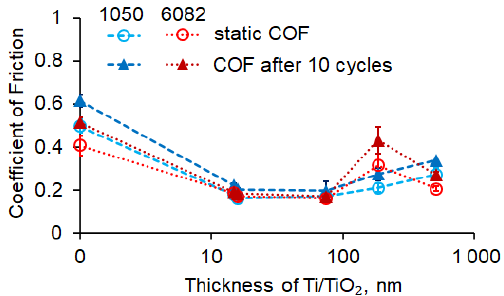
Figure 5. Influence of Ti layers thickness on static friction (hollow signs) and friction after 10 cycles (solid signs) on anodized 1050 and 6082 alloys.